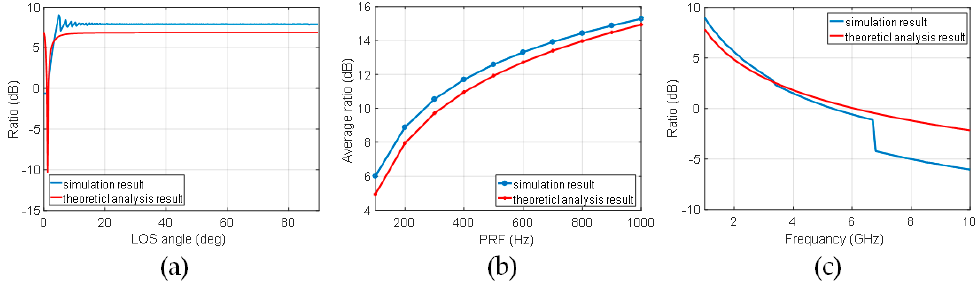
ϑ ϑ (L band); ( b ) average ratio (averaged by within 0°–90°) ϑ = 90°).